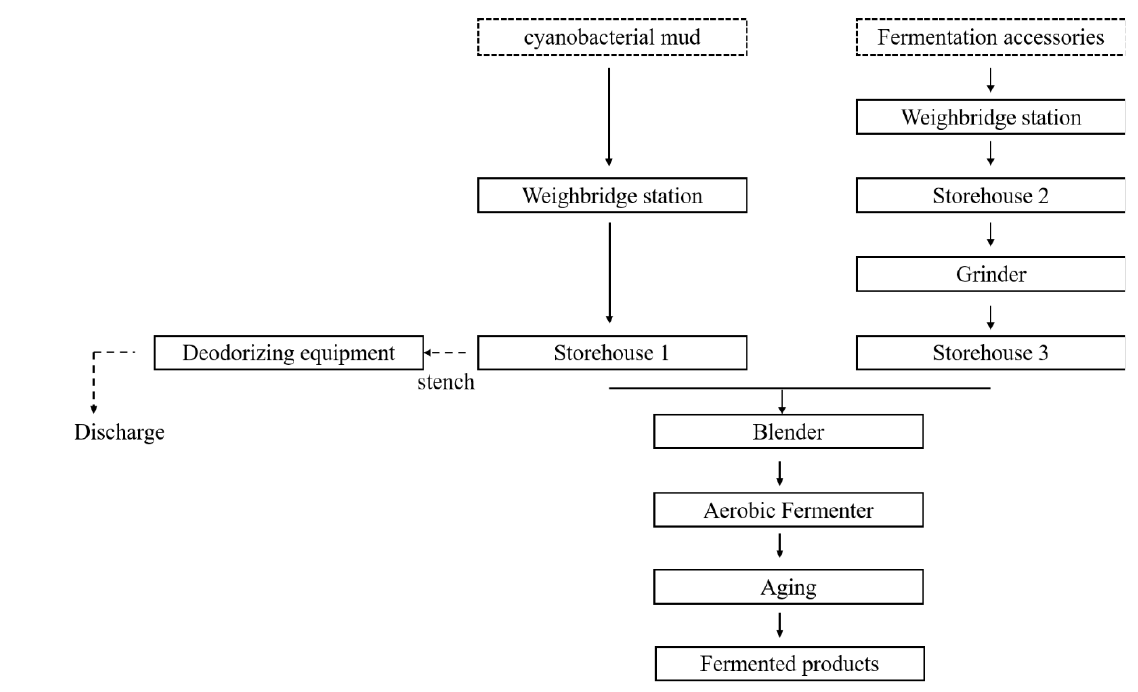
Figure 4. Process flowchart of aerobic fermentation with auxiliary materials.